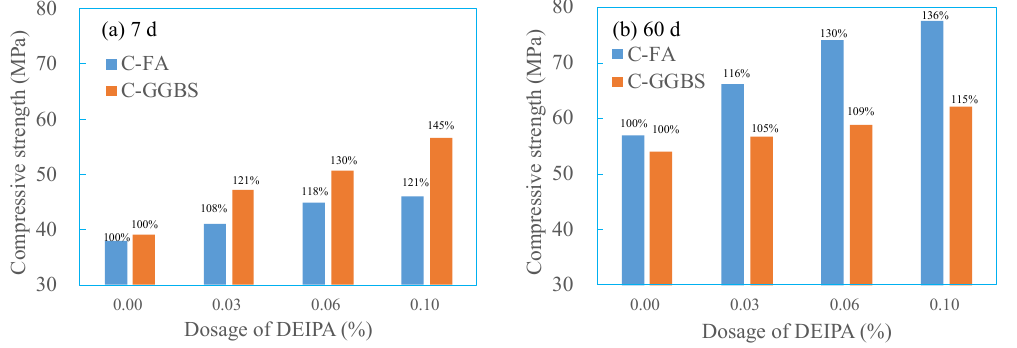
Figure 5. Effect of DEIPA on compressive strength of the paste, ( a ) 7 d, ( b ) 60 d.